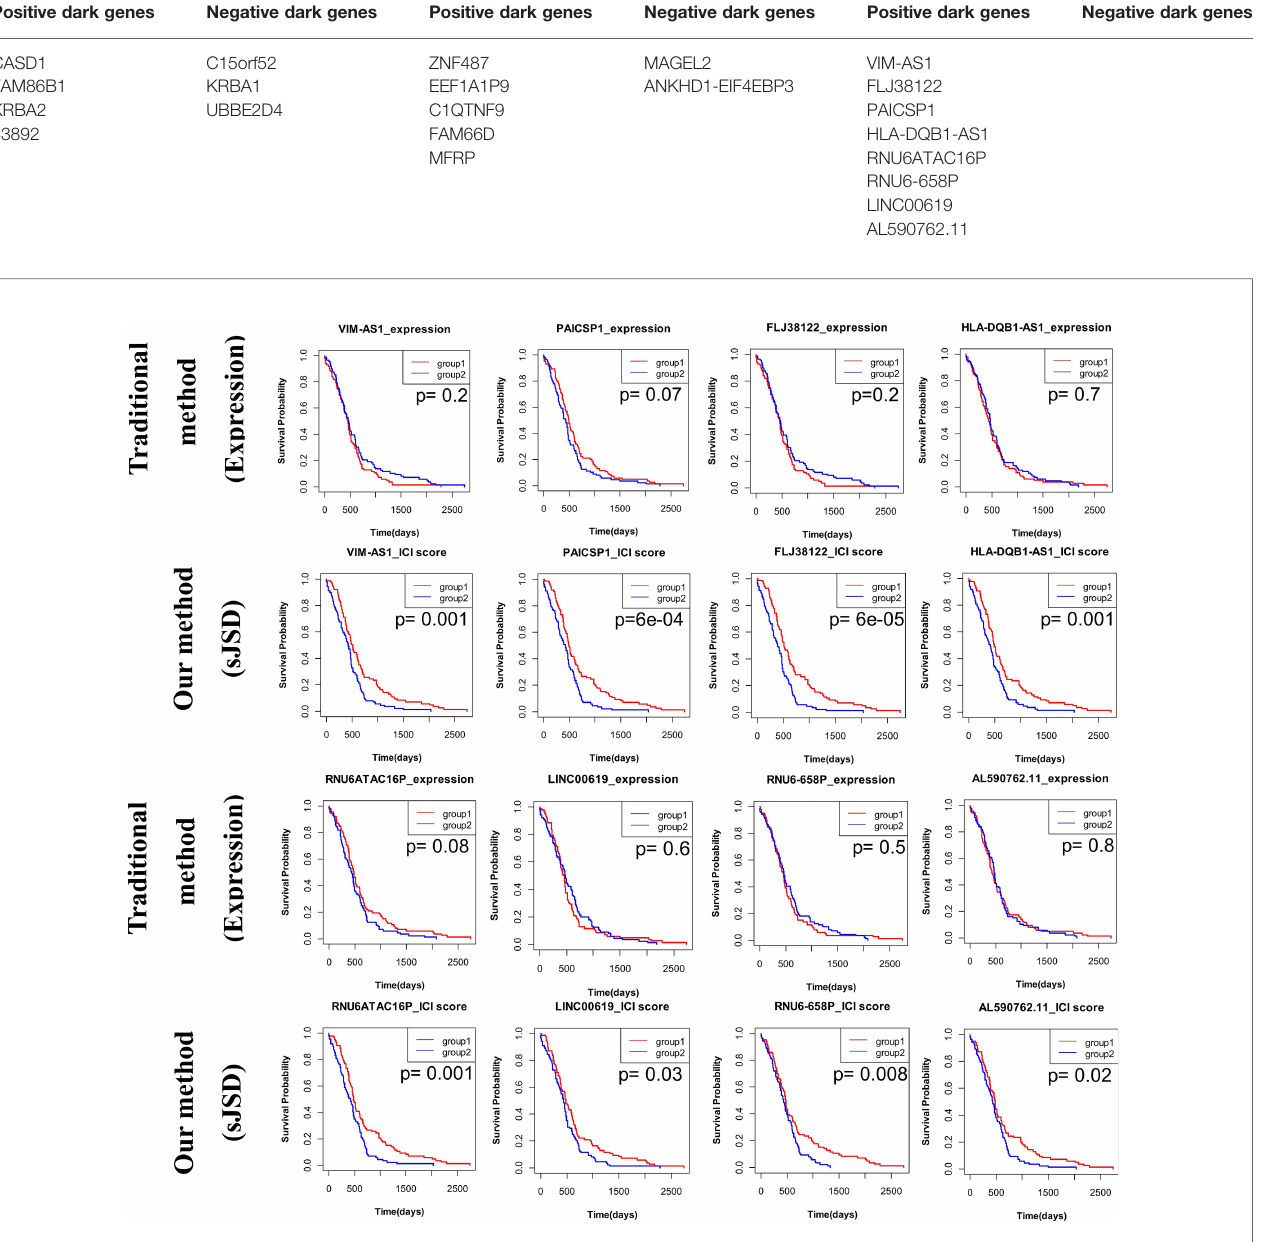
FIGURE 11 | The prognosis analysis based on ‘ dark genes ’ of PAAD. The prognosis of these “ dark genes ” respectively based on gene expression and ICI score by dividing the samples into two groups based on the median of genes expression or ICI score, in which Group 1 is a group with higher values and Group 2 is a group with lower values. Eight genes VIM-AS1, FLJ38122, PAICSP1, HLA-DQB1-AS1, RNU6ATAC16P, RNU6-658P, LINC00619, and AL590762.11, none of which is differentially expressed in stage IB (the critical stage before distant metastasis), perform well in CESC prognosis. All of these genes are ‘ positive dark genes ’ .